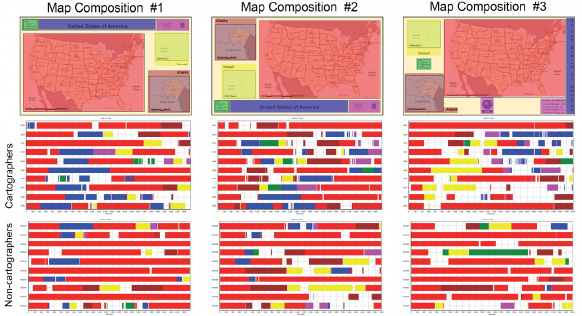
Figure 7. Sequence chart visualisation of participant read- ing strategy of three different map compositions. Map composi- tion #1 was used for a model case